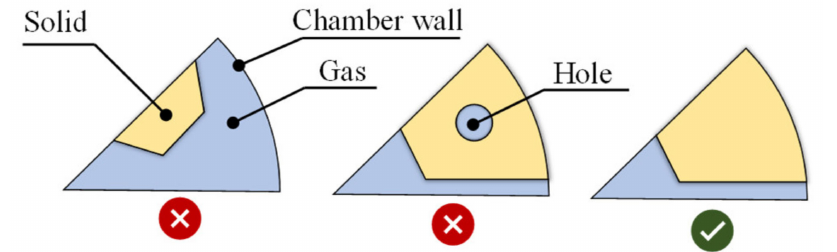
Figure 14. Possible grain structure generated by the neural